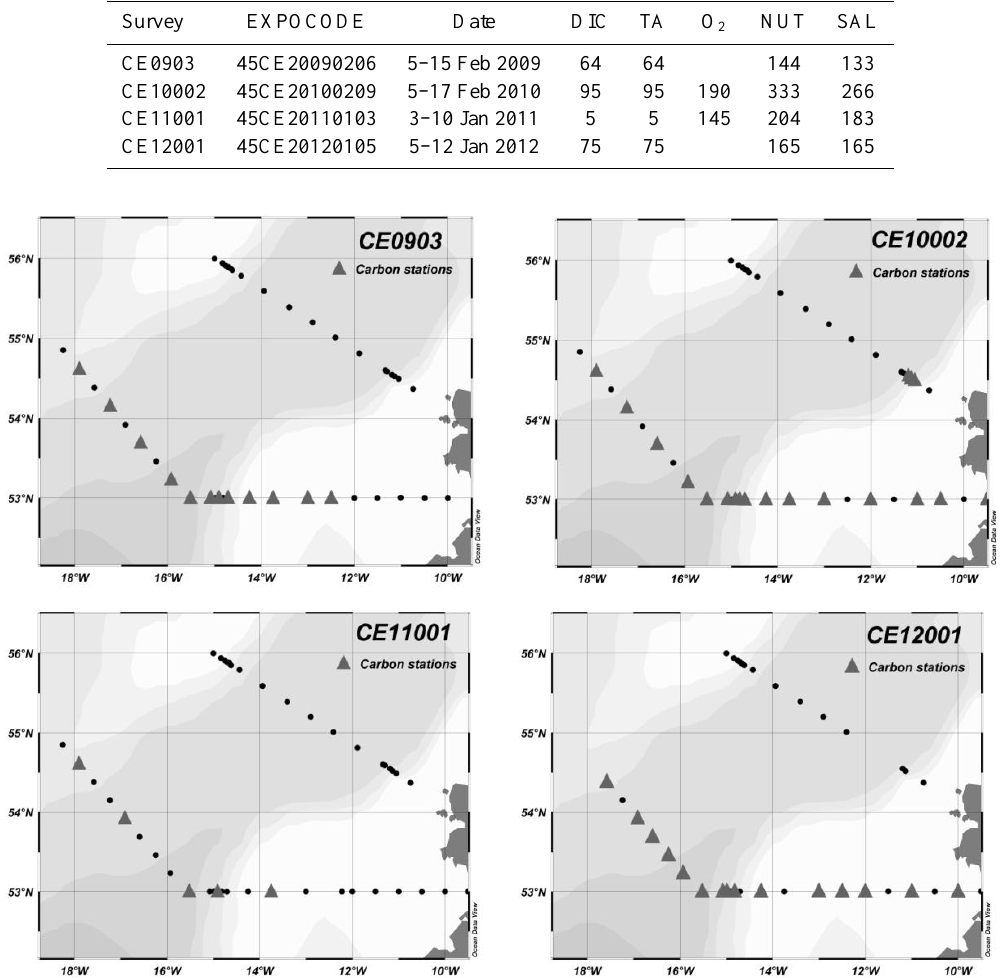
Figure 1. Station positions from the surveys CE0903 (February 2009), CE10002 (February 2010), CE11001 (January 2011) and CE12001 (January 2012). Stations with triangle symbols are where carbonate parameters were measured. Note in CE11001 only surface samples were taken, in other years samples were taken through the water